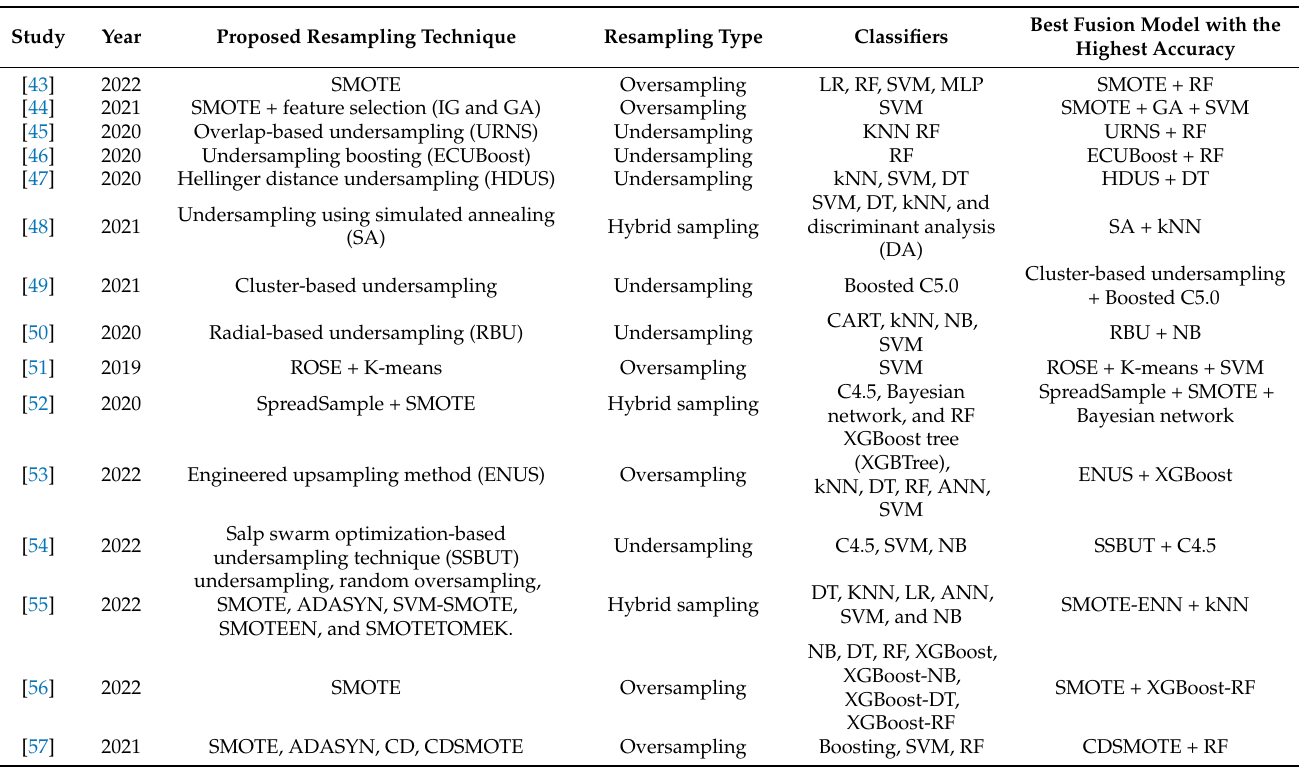
Table 3. Summary of the reviewed studies using resampling techniques in Breast Cancer